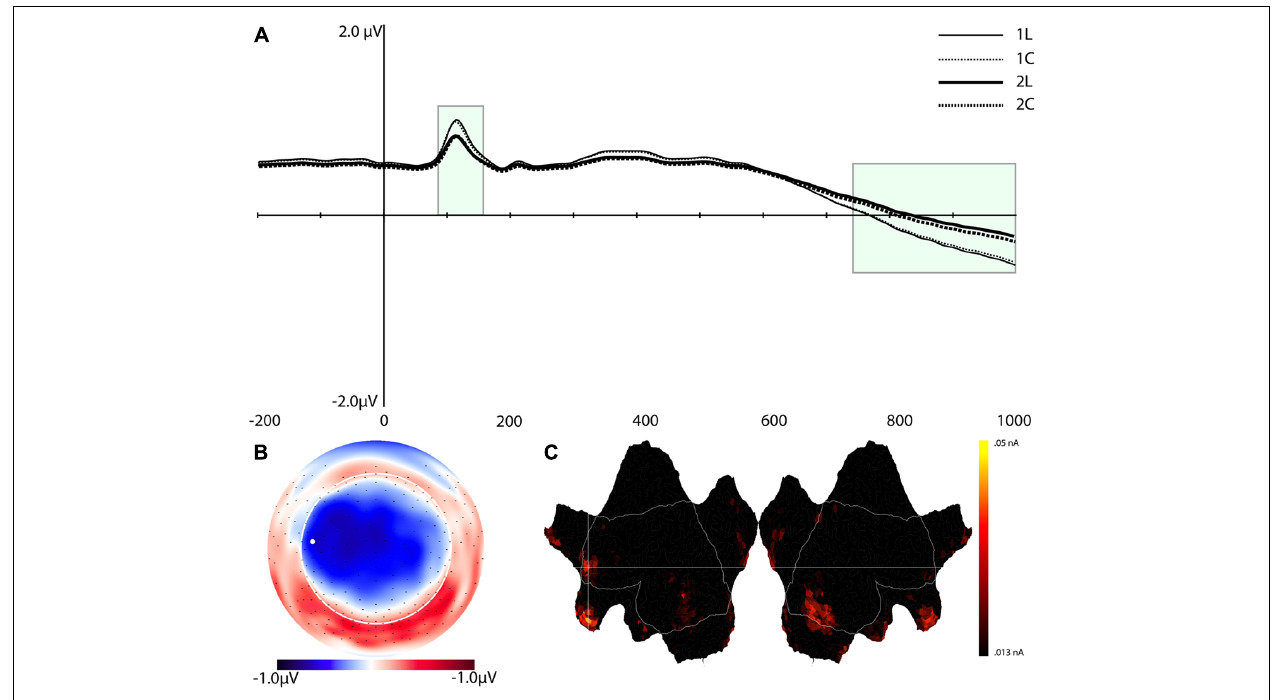
FIGURE 6 | Component 7 (C7). (A–C) are as in Figure 4 .